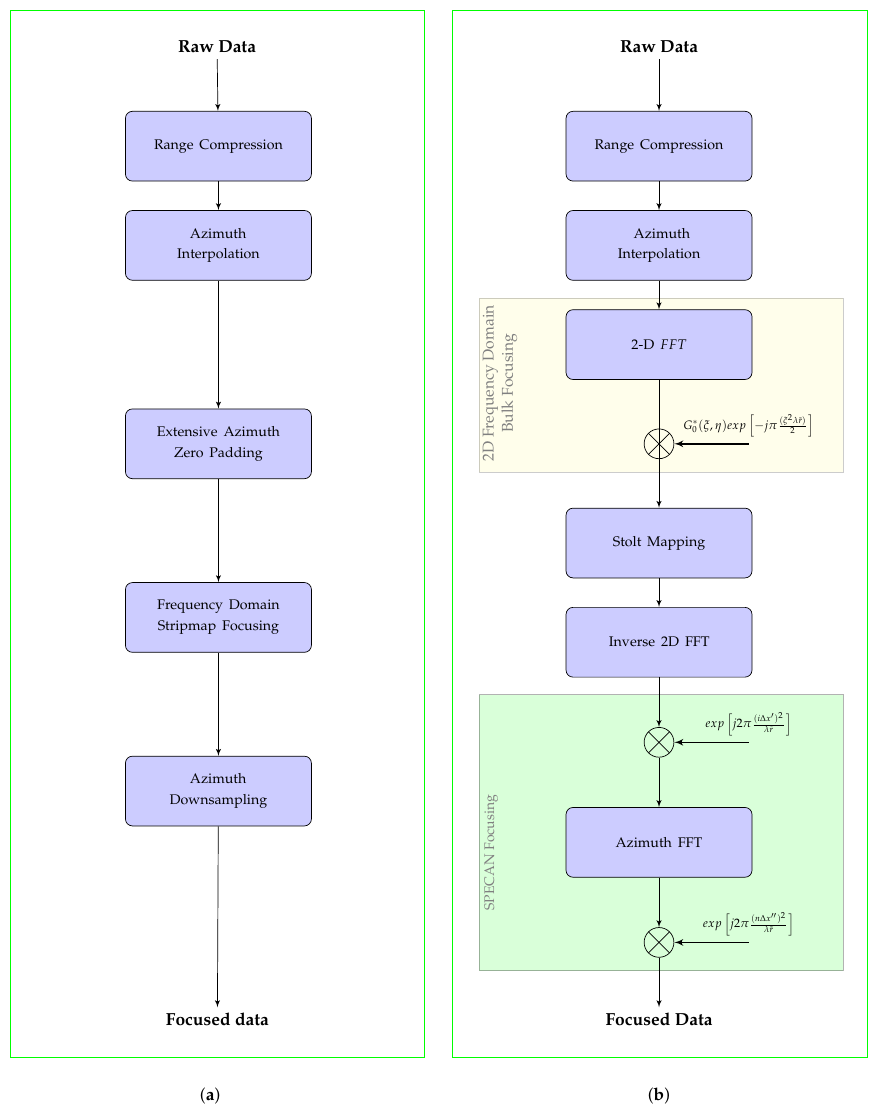
Figure 5. ( a ) Flow chart of a straightforward Stripmap-based TOPS raw data focusing algorithm; ( b ) Flow chart of the proposed TOPS raw data focusing